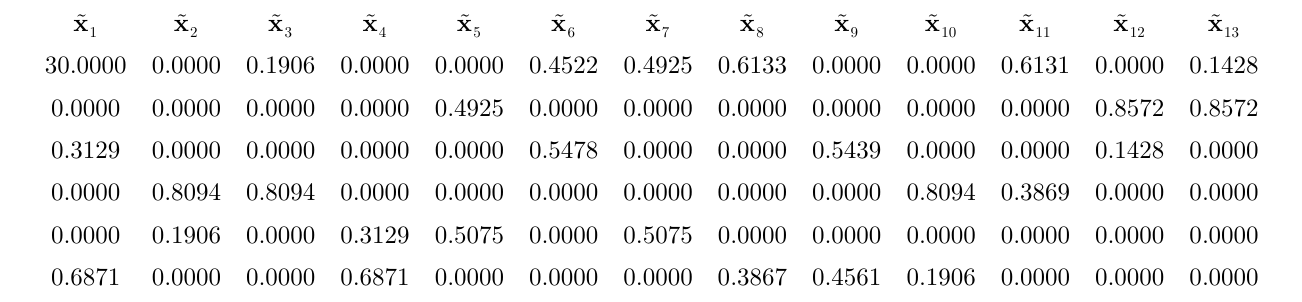
is D -optimal design for the cubic mixture P constrained ; D 3 x ¼ 1 , 0 (cid:2) x 1 (cid:2) 0.5 and 0 (cid:2) x 2 , x 3 (cid:2) i i ¼ 1